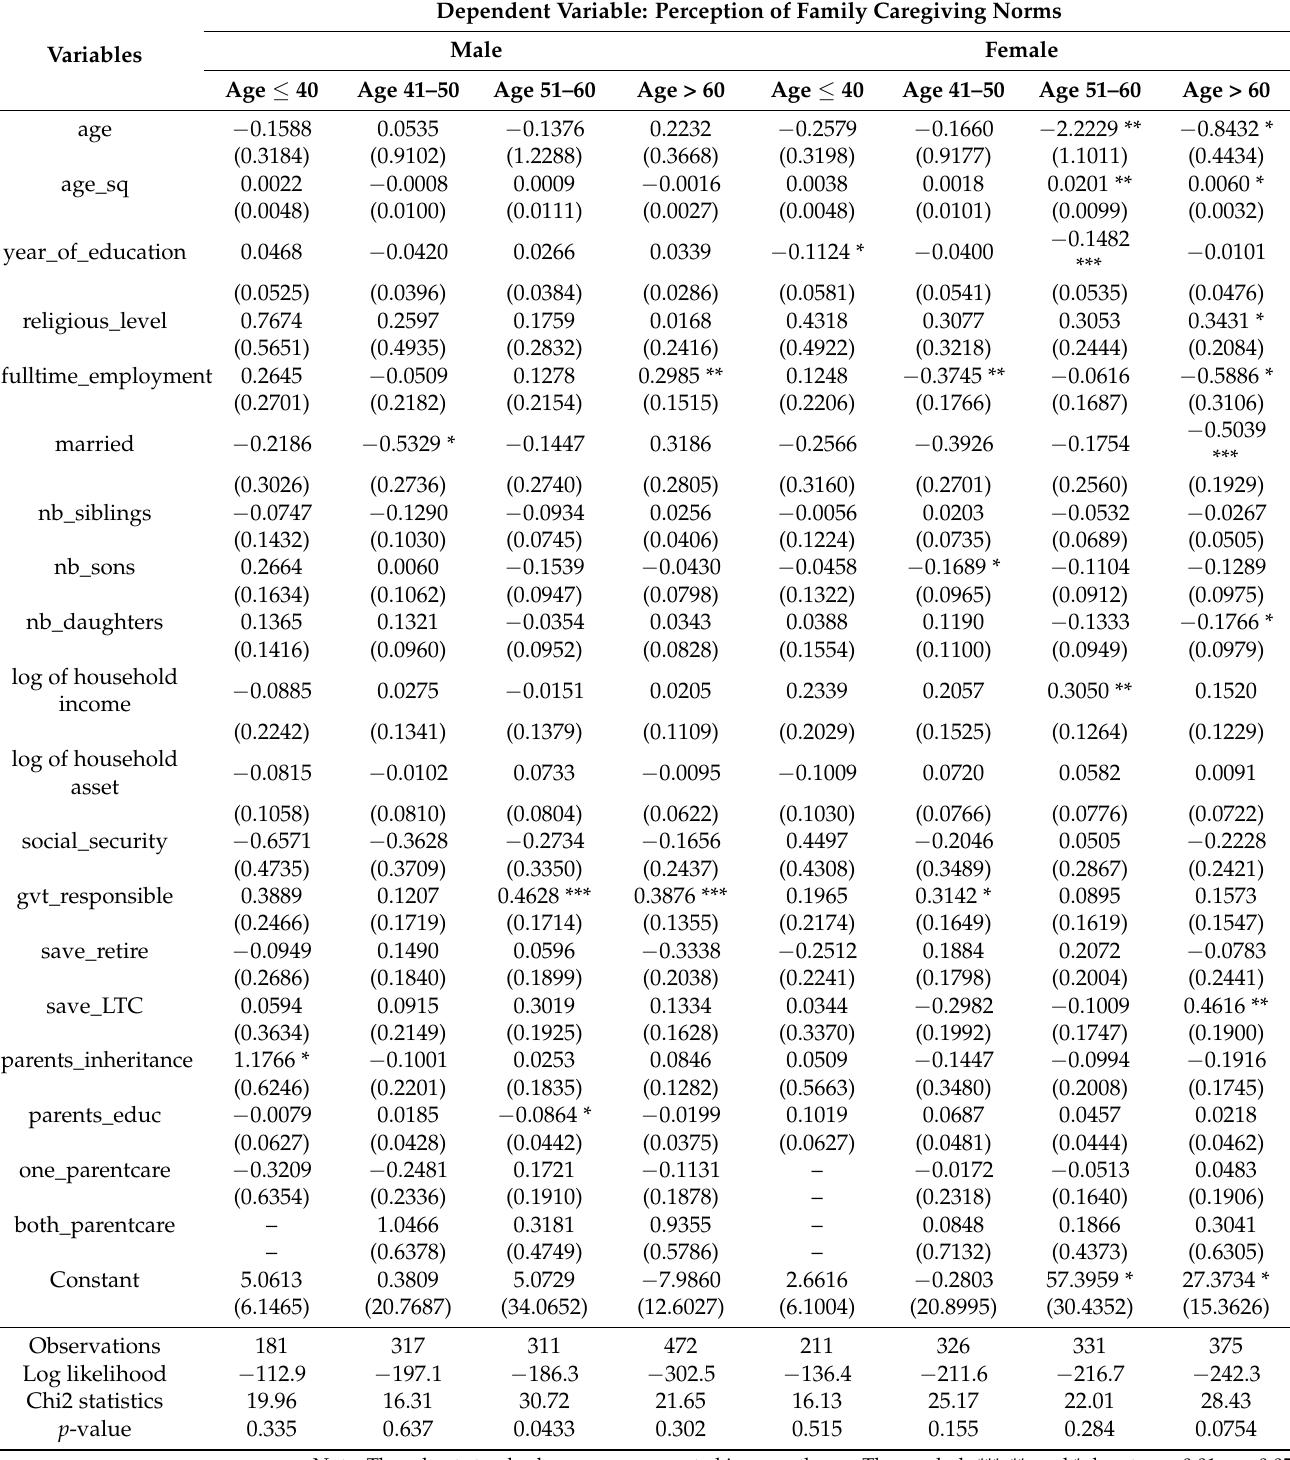
Table 6. Perception of family caregiving norms by sex and age: subsample regression